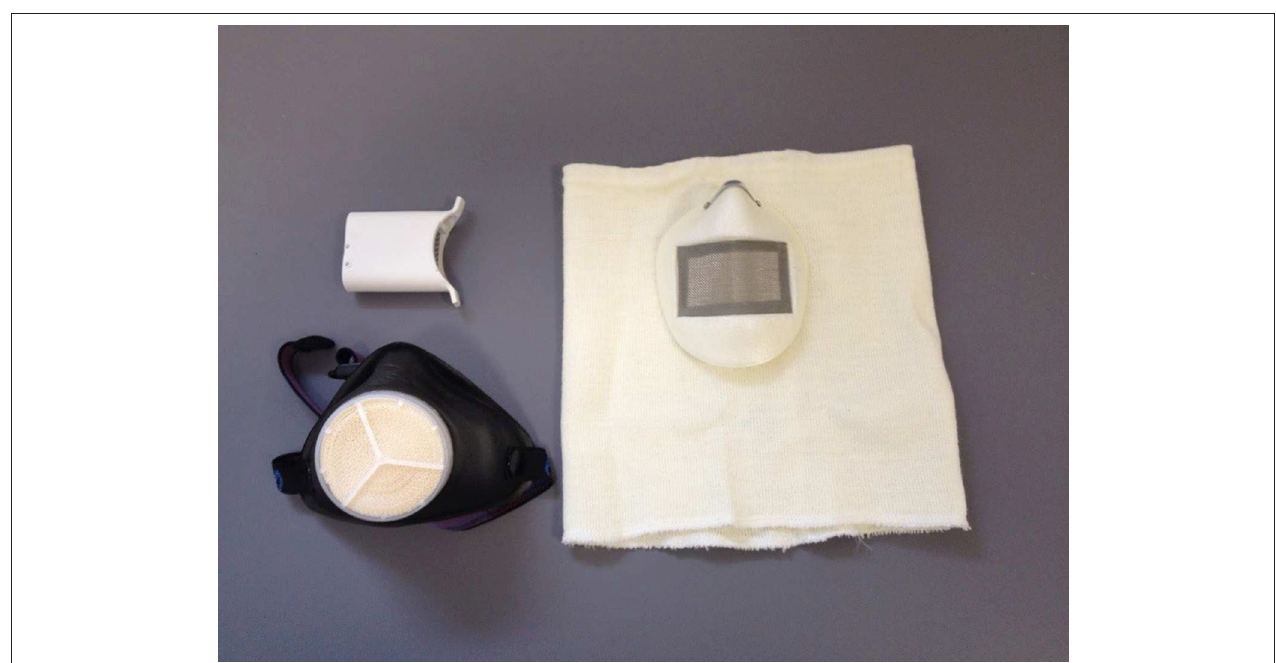
FIGURE 2 | Three representative types of HME: Lungplus (upper left), AirTrim (lower left), and Jonaset 0602 (right).